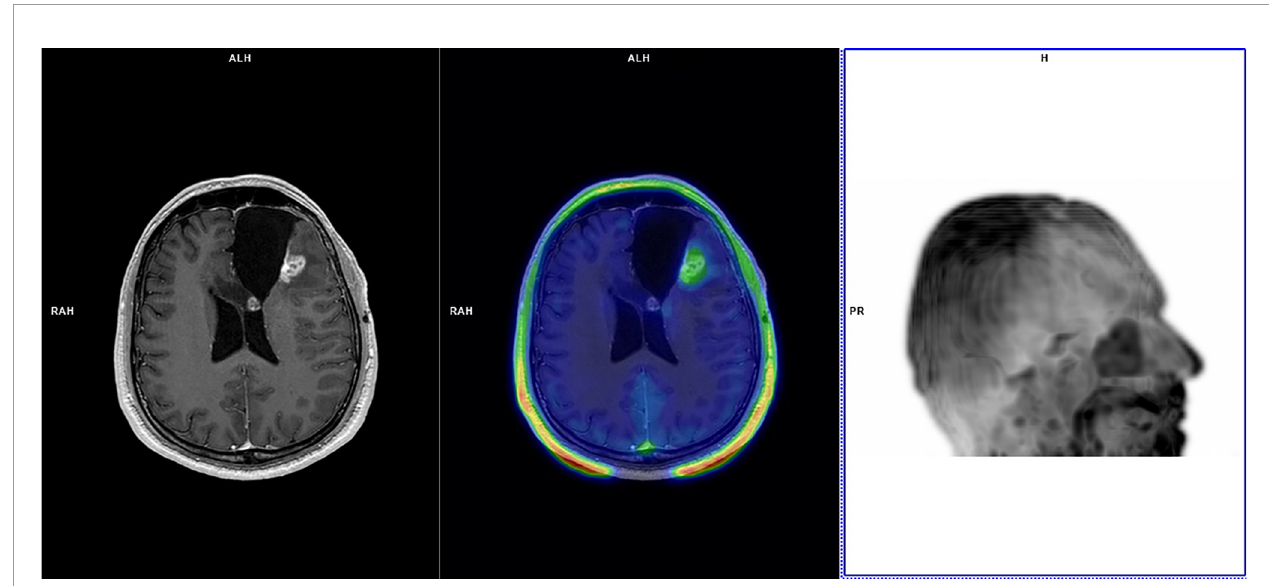
FIGURE 1 | A 35-year-old patient with left frontal glioblastoma (IDH wild-type; MGMT methylated) treated with partial resection in August 2017, chemoradiation (completed in November 2017), and four cycles of adjuvant temozolomide (last cycle in March 2018). In August 2018, left frontal cavity re-irradiation was performed for glioblastoma relapse. Follow-up MRI scans in November 2018 demonstrated an increasing pseudonodular area of contrast-enhancement along the left frontal surgical cavity without functional indices abnormalities, deemed dubious for GR. 18 F-FET PET performed in December 2018 demonstrated faint tracer uptake at late static imaging (TBRmax: 1.6) and TAC pattern 3 with TTP at 35 min. 18 F-FET PET was considered suggestive of TICs. MRI demonstrated disease progression in August 2019 (PFS: 8 months; OS not reached), and bevacizumab was commenced. At last MRI follow-up (January 2021) MRI demonstrated stable